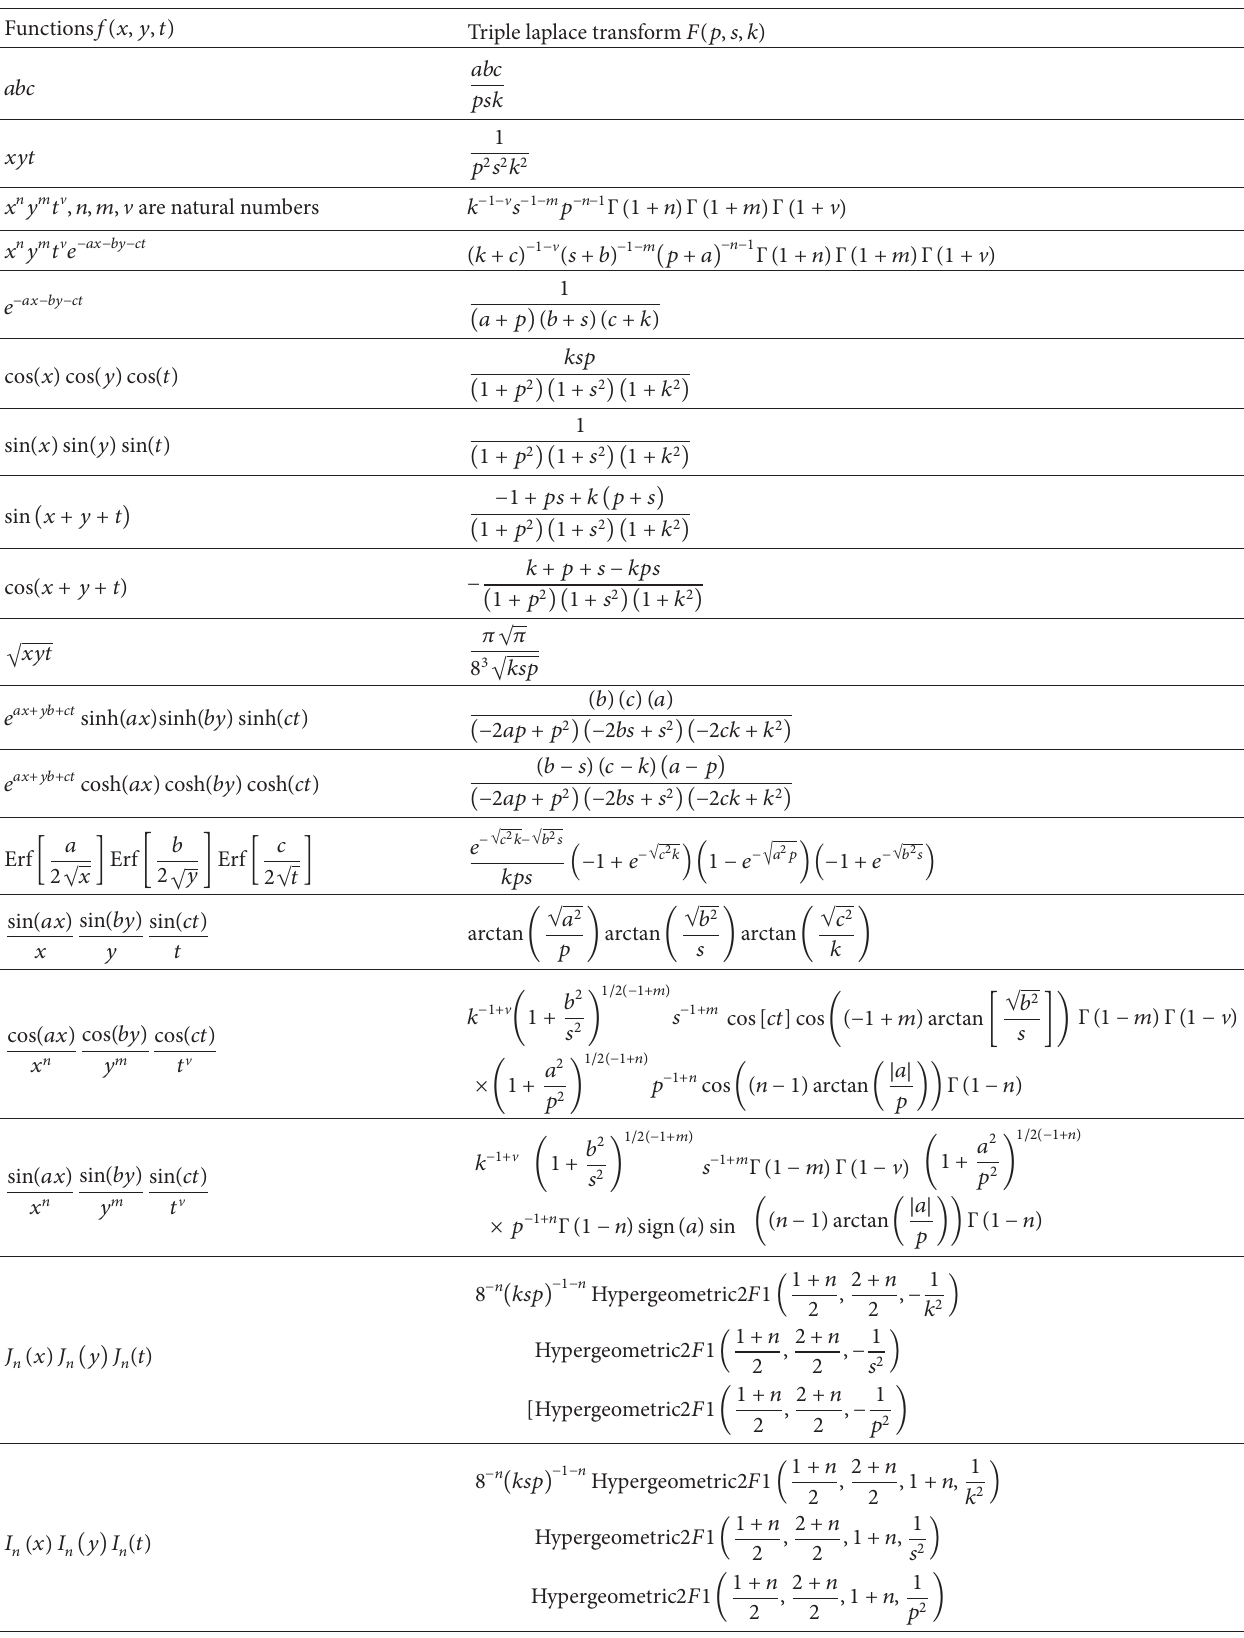
Table 1: Table of triple Laplace transform for some function of three